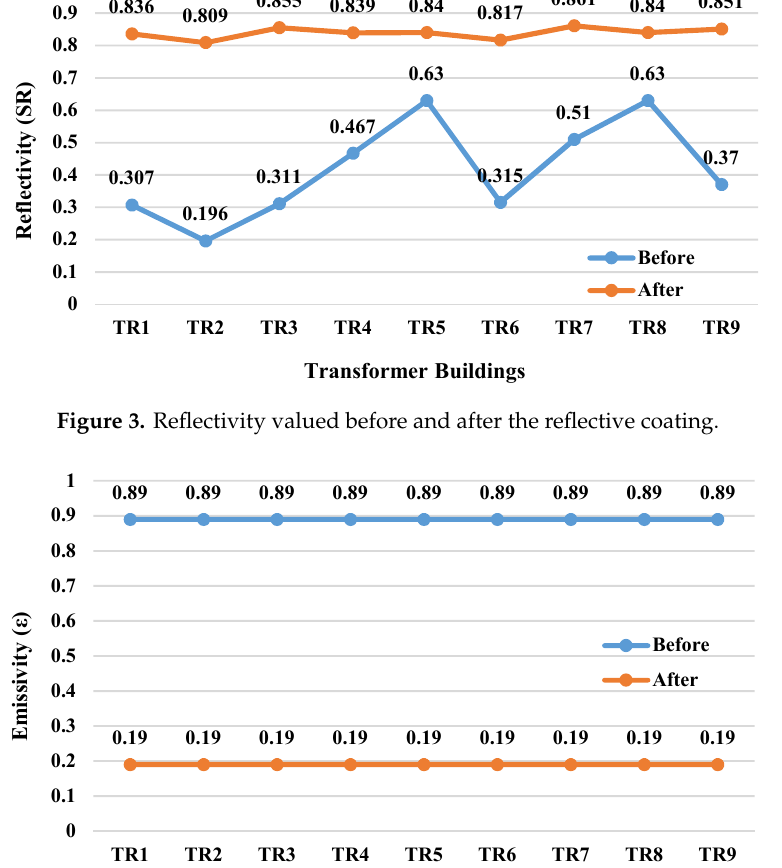
Figure 5. Results obtained by using the mathematical calculation method and the maximum daily measurement values in TR6 before the proposed insulation.